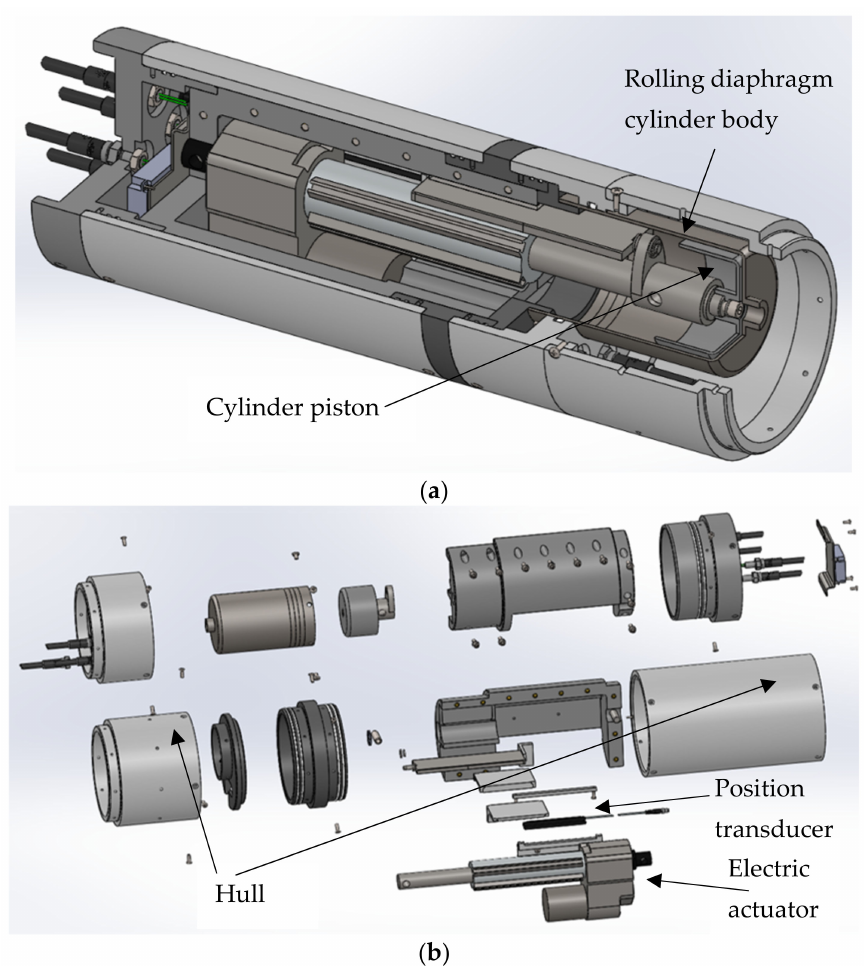
Figure 3. ( a ) 3D rendering of the cross section of the BCM; ( b ) exploded